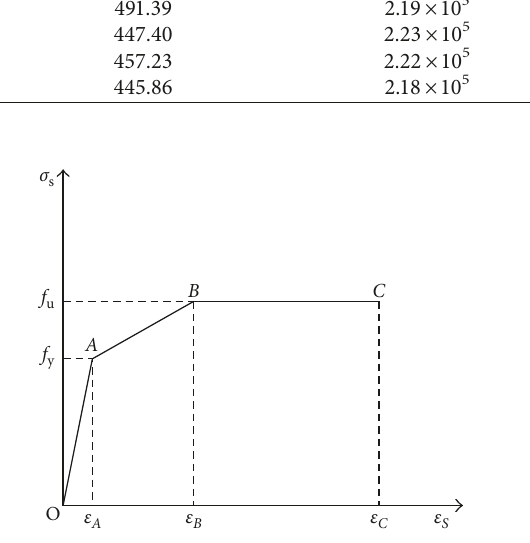
Figure 8: Constitutive trilinear stress-strain relationship.